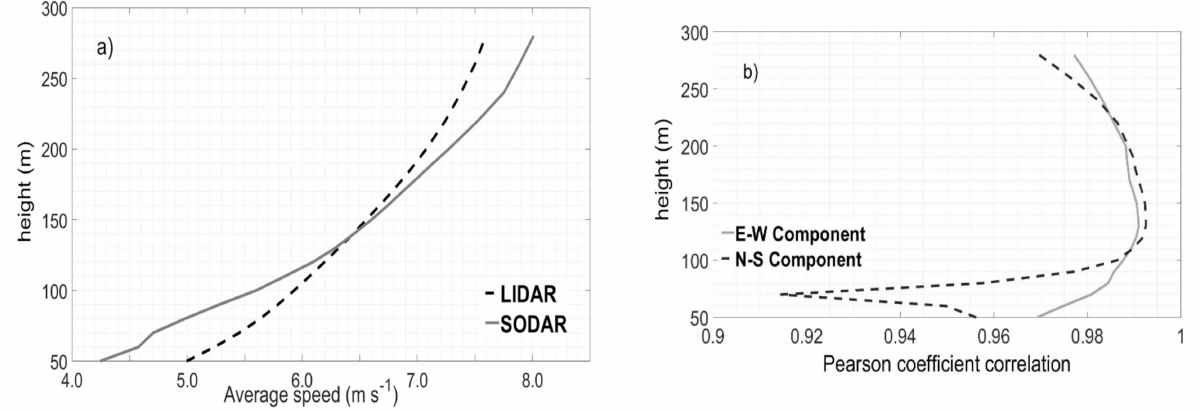
Figure 9. ( a ) Vertical profiles of wind speed measured by LIDAR and SODAR. ( b ) Vertical distribution of the Pearson’s correlation coefficient comparing LIDAR and SODAR in terms of their zonal and meridional wind